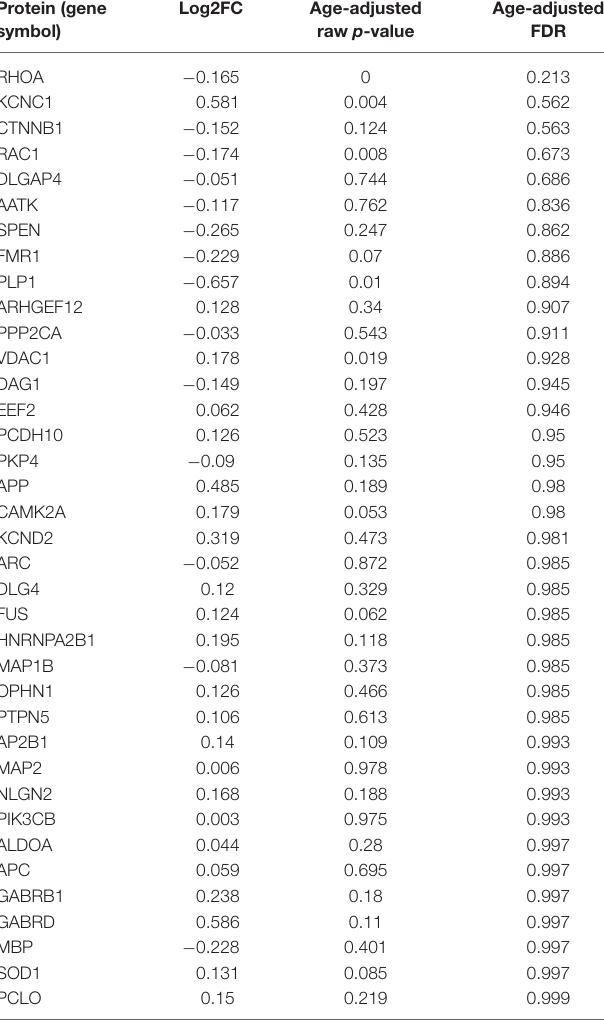
TABLE 3 | Proteins translated from FMRP-associated mRNA in FXTAS cortex. Protein (gene symbol)